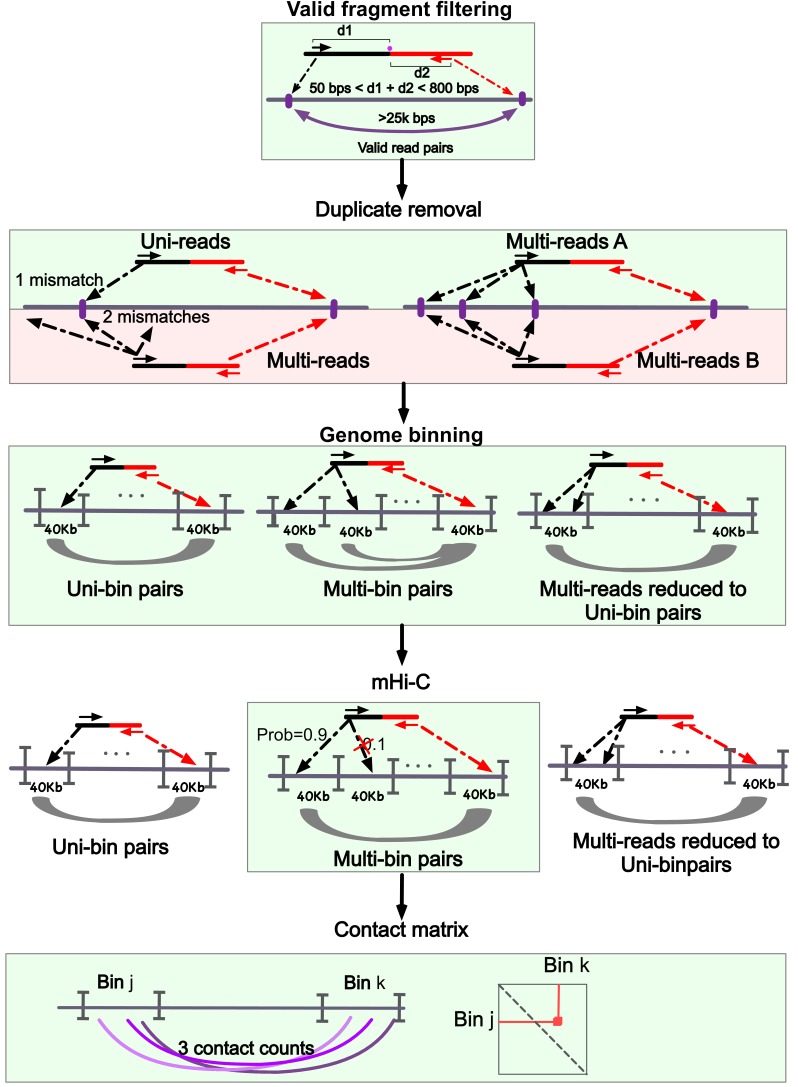
mHi-C pipeline (Duplicate removal - Genome binning - mHi-C).4. PCR duplicates are removed to ensure that when a uni-read and a multi-read have the same alignment position and strand direction, the uni-read is kept. In the case of multi-reads that overlap with other multi-reads, the ones with alphabetically larger IDs are removed. 5. Genome is split into fix-sized non-overlapping intervals, that is bins or a fixed number of restriction fragments and, as a result, read alignment position pairs are reduced to bin pairs. Multi-reads, candidate alignment positions of which fall into the same bin, are reduced to uni-bin pairs. 6. mHi-C model estimates an allocation probability for each potential contact and enables filtering of contacts by thresholding this allocation probability.